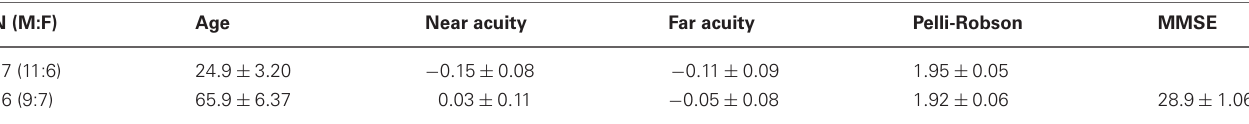
Table 1 | Mean ± 1SD age, near and far logMAR acuity, Pelli-Robson contrast sensitivity, and mini-mental state examination